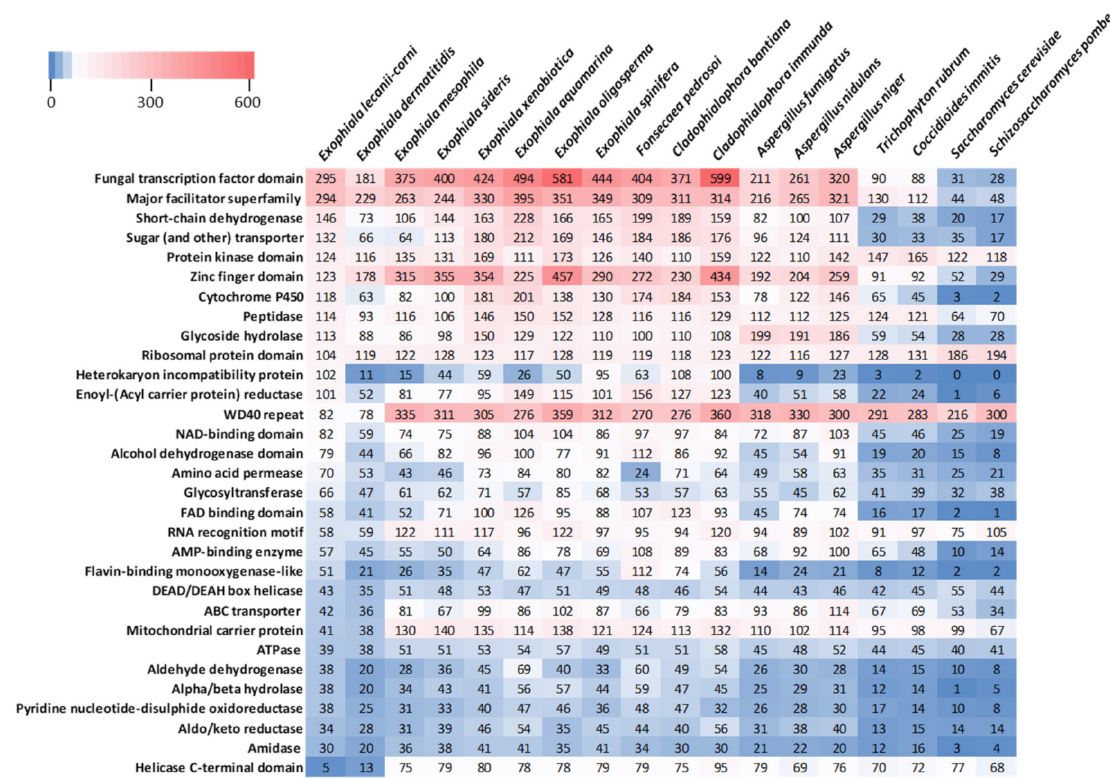
Figure 6. Pfam database protein domain count, as predicted using the PfamScan Perl script, in the E. lecanii-corni relative to other fungi included in this